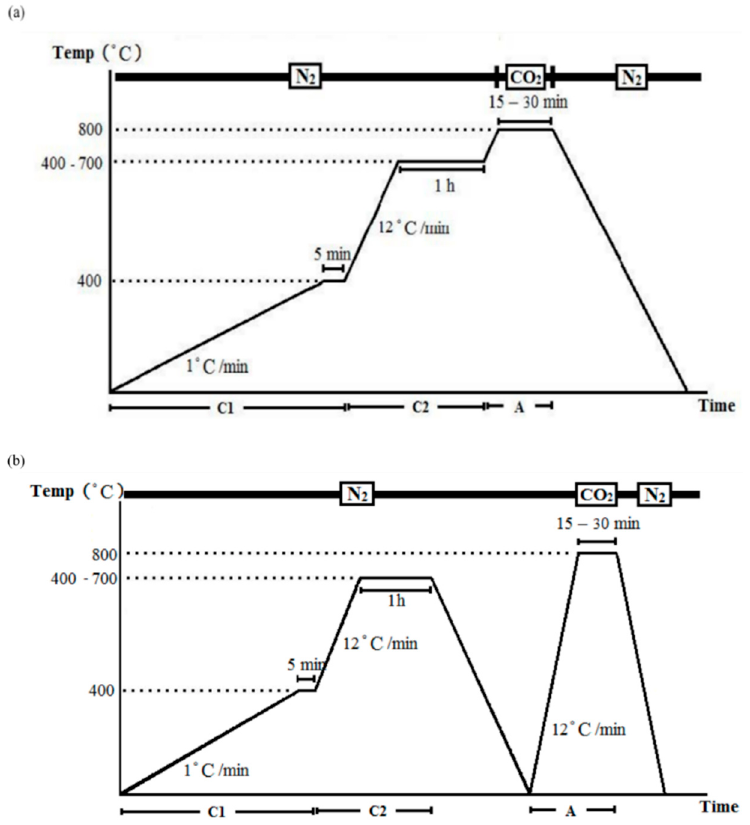
Figure 2. Carbonization and activation: ( a ) one-step process and ( b ) two-step process.